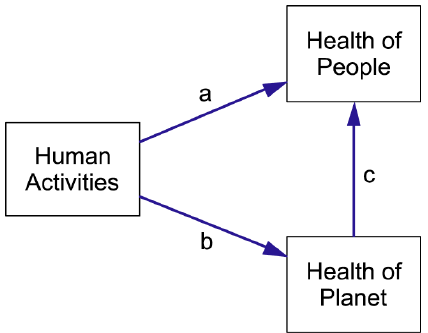
Figure 3. Boyden’s Biosensitivity Triangle (modified to reflect our focus on human activities). The arrows have been labelled for ease of